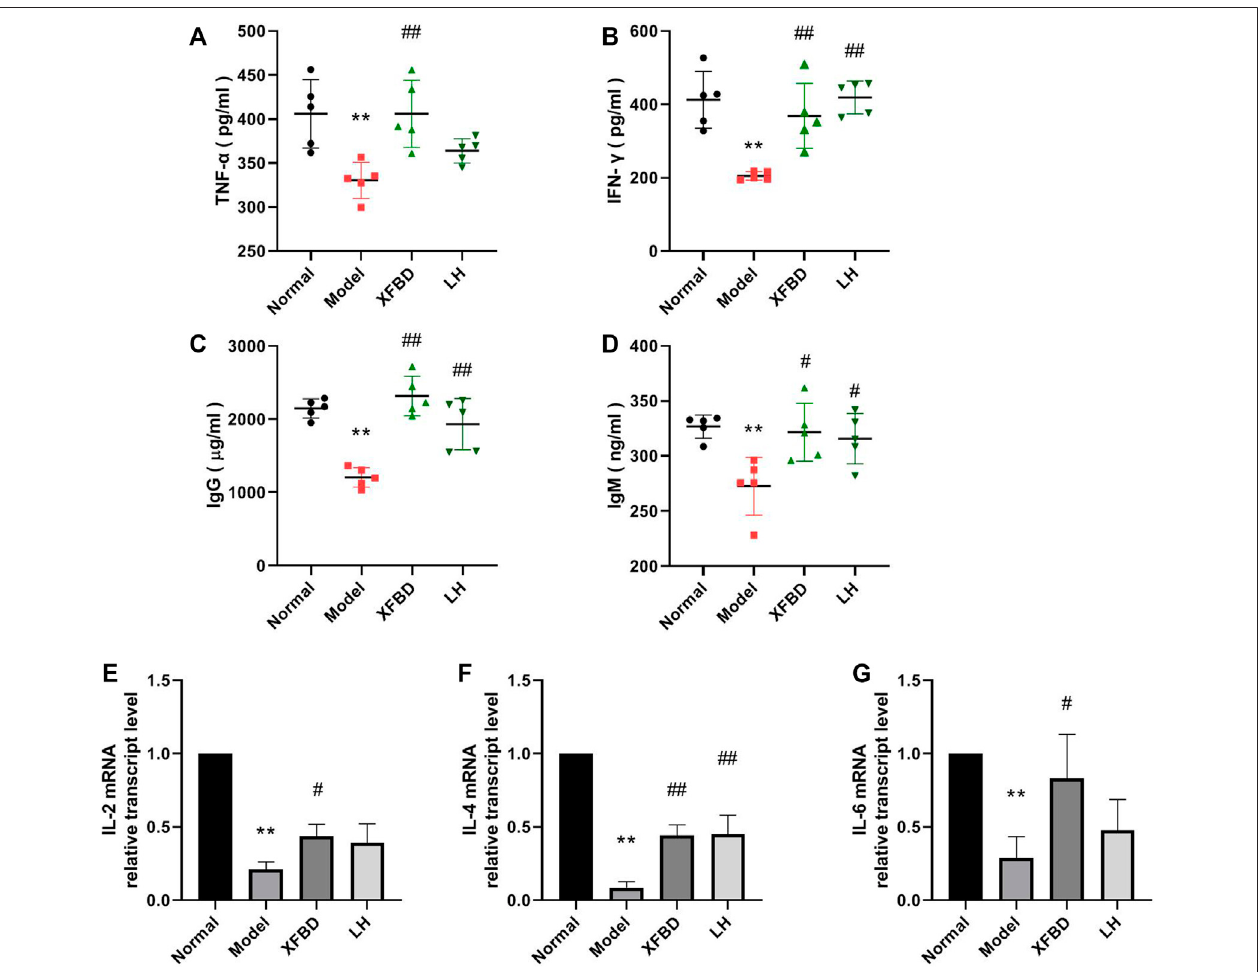
FIGURE 3 | Effect of XFBD on immunoglobulin levels and cytokines in the CY-treated mice. TNF- α (A) , IFN- γ (B) IgG (C) , and IgM (D) levels in serum were determined by ELISA and IL-2 (E) , IL-4 (F) , and IL-6 (G) expressions in the spleen were determined by RT-PCR. Normal, administered with saline; Model: intraperitoneallyadministeredwithcyclophosphamide;XFBD:intraperitoneallyadministeredwithcyclophosphamide fi rstandfollowedbyXFBDat3.9 g/kg/day;andLH: intraperitoneally administered with cyclophosphamide fi rst and followed by LH at 20 mg/kg. Data are expressed as mean ± SD [ (A – D) , n (cid:2) 5] [ (E – F) , n (cid:2) 3]. * p < 0.05 and ** p < 0.01 vs. Normal group, # p < 0.05 and ## p < 0.01 vs. Model